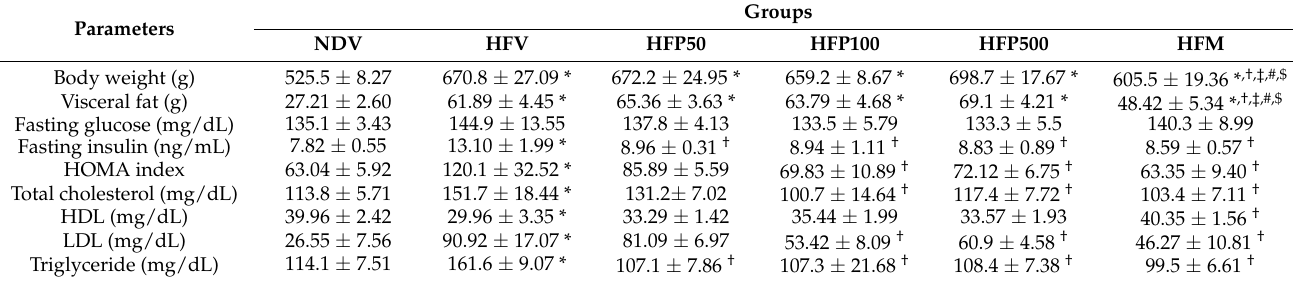
Table 1. Effects of PSO and metformin treatment on metabolic parameters in rats. Parameters